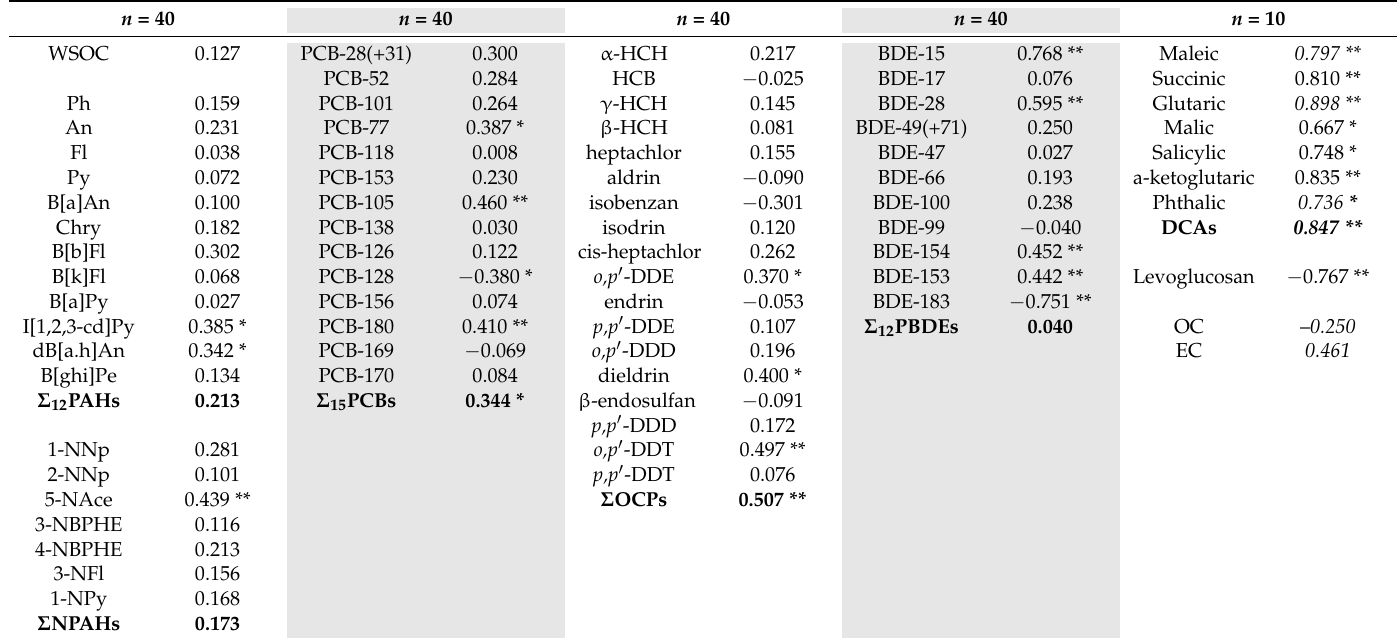
Table 2. Spearman and Pearson (italicized values) correlation coefficients between the mass-normalized DTT activity and the content of organic chemical components in PM from the urban traffic site